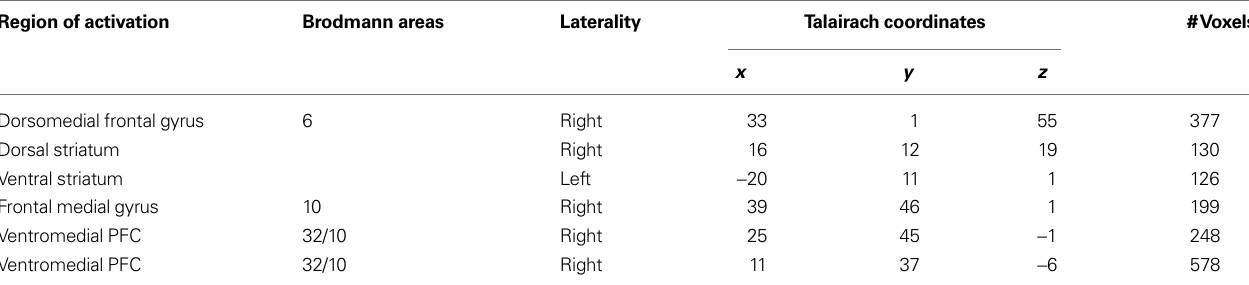
Table 2 | Contrast of AV + and AV − trials at p < 0.005 and contiguity threshold of four voxels. Region of